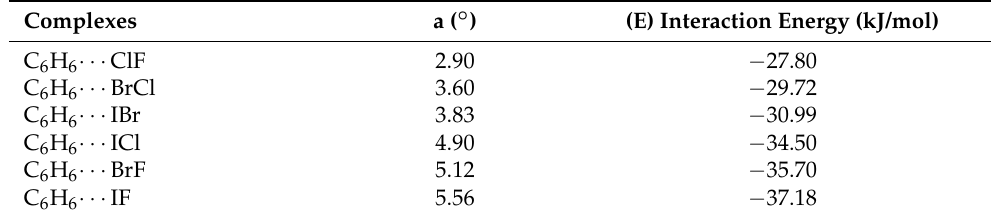
Table 1. The values of the interaction energy and the angle of a. Complexes a (°) (E) Interaction Energy (kJ/mol) C 6 H 6 ⋯ ClF